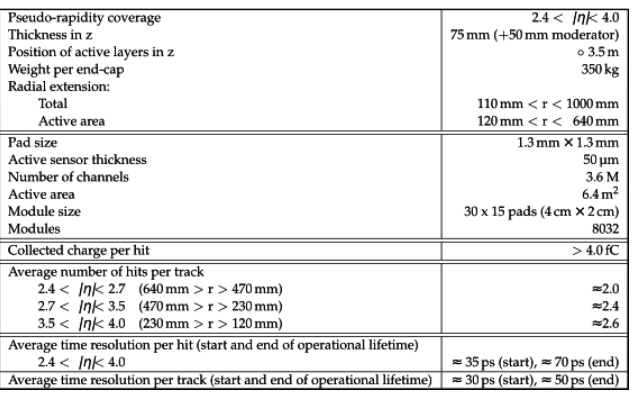
Fig. 2: Main parameters of HGTD